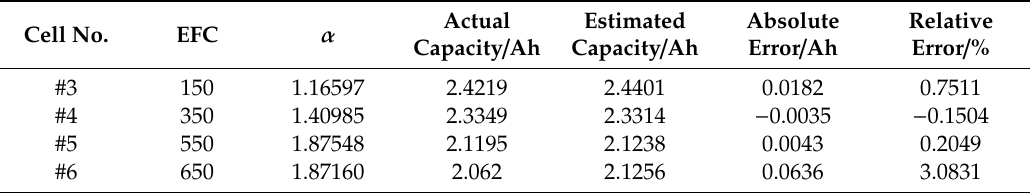
Table 4. Estimated results of α -based capacity estimation method at 40% SOC under discharging condition.